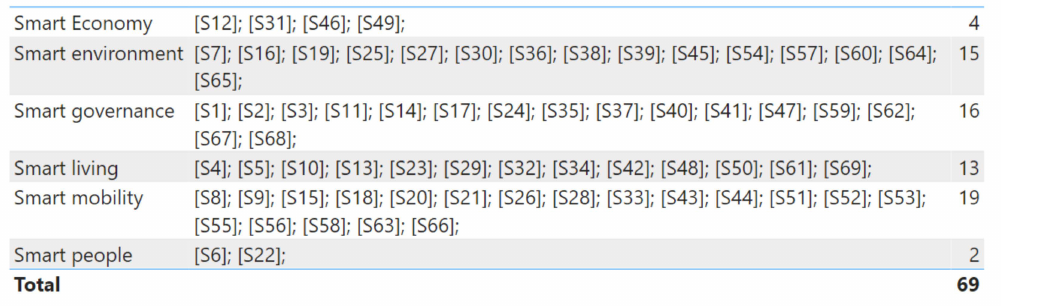
Figure 6. List of papers classified by smart city areas considered in proposed applications. RQ1. Which Learning Types and Algorithms Are Used in Open Data Based ML Applications for each of the Smart City